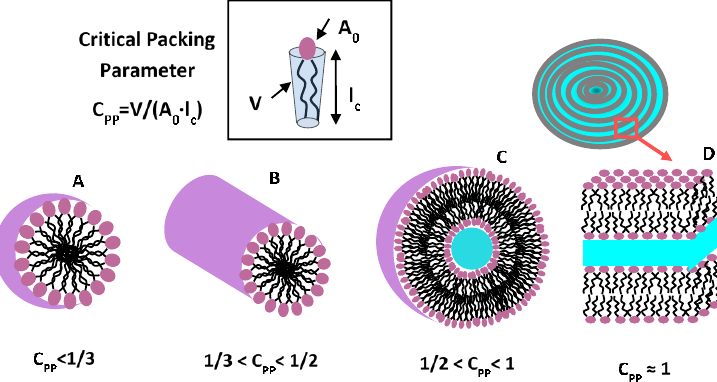
Figure 1. Relevant shape factor influencing nanocarrier morphology. Aggregate structures of amphilphilic molecules can be predicted from the critical packing parameter Cpp .